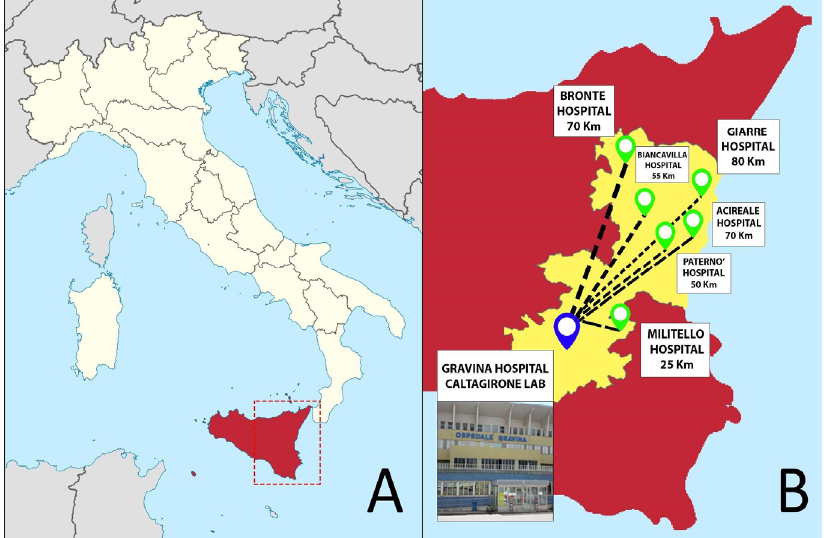
Figure 1. ( A ), Location of the Catania area in Sicily, south of Italy. ( B ), the different hospitals in the Catania territory referring to the Caltagirone pathology laboratory at Gravina Hospital.